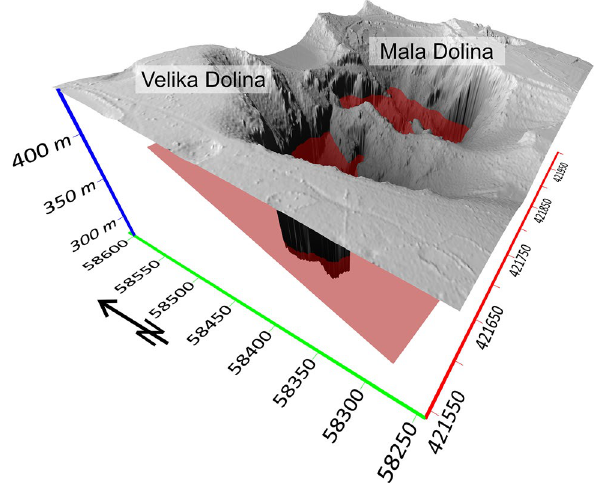
Fig. 7 3D model of Velika and Mala Dolina with stratigraphic boundary (red plane) between older Lipica and younger Sežana Formations, DEM after